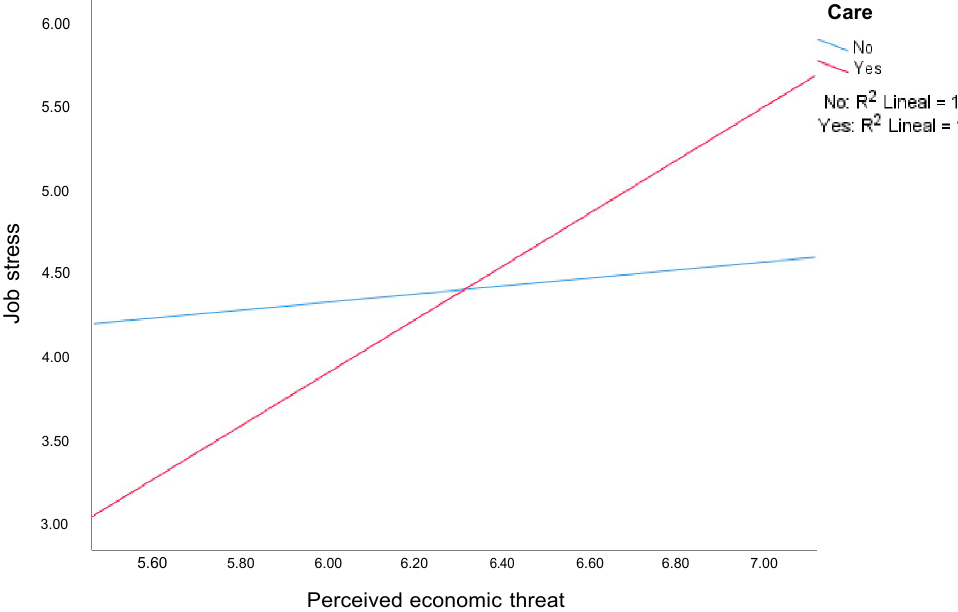
Figure 1. Influence of perceived economic threat on work-related stress as a function of caregiving in a face-to-face work